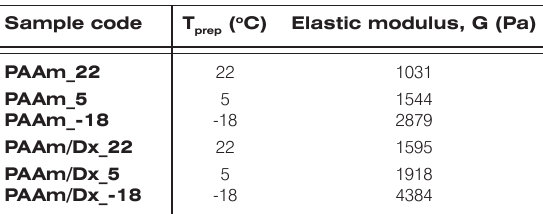
0.0 Figure 3. Typical stress-strain data for PAAm hydrogels prepared at 22 o C ( □ ), 5 o C ( ○ ) and -18 o C ( ∆ ) and for PAAm/Dx semi- IPN hydrogels prepared at 22 o C ( ■ ), 5 o C ( ● ) and -18 o C ( ▲